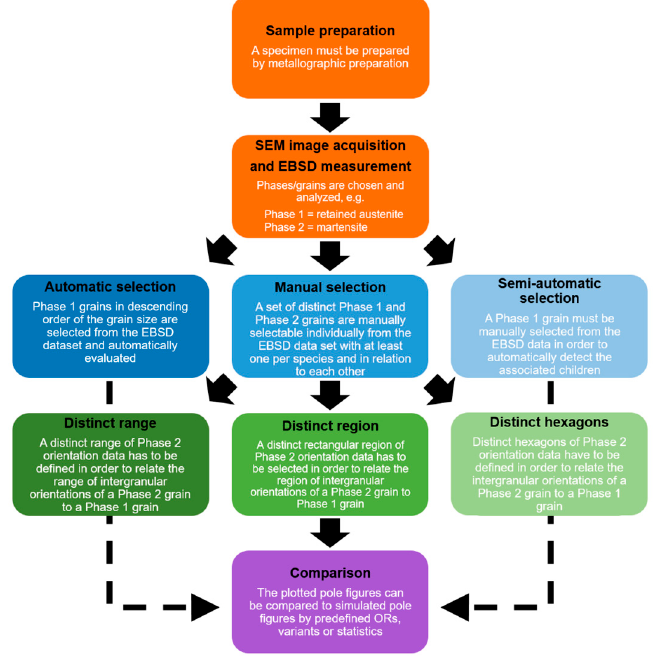
Figure 2. Workflow of the OR analysis code. Orange segments show preceding preparations and measurements, blue shows modes 1, 2 and 3, whereas green illustrates the three submodes of mode 2 and purple depicts potential analysis after the code has been executed.